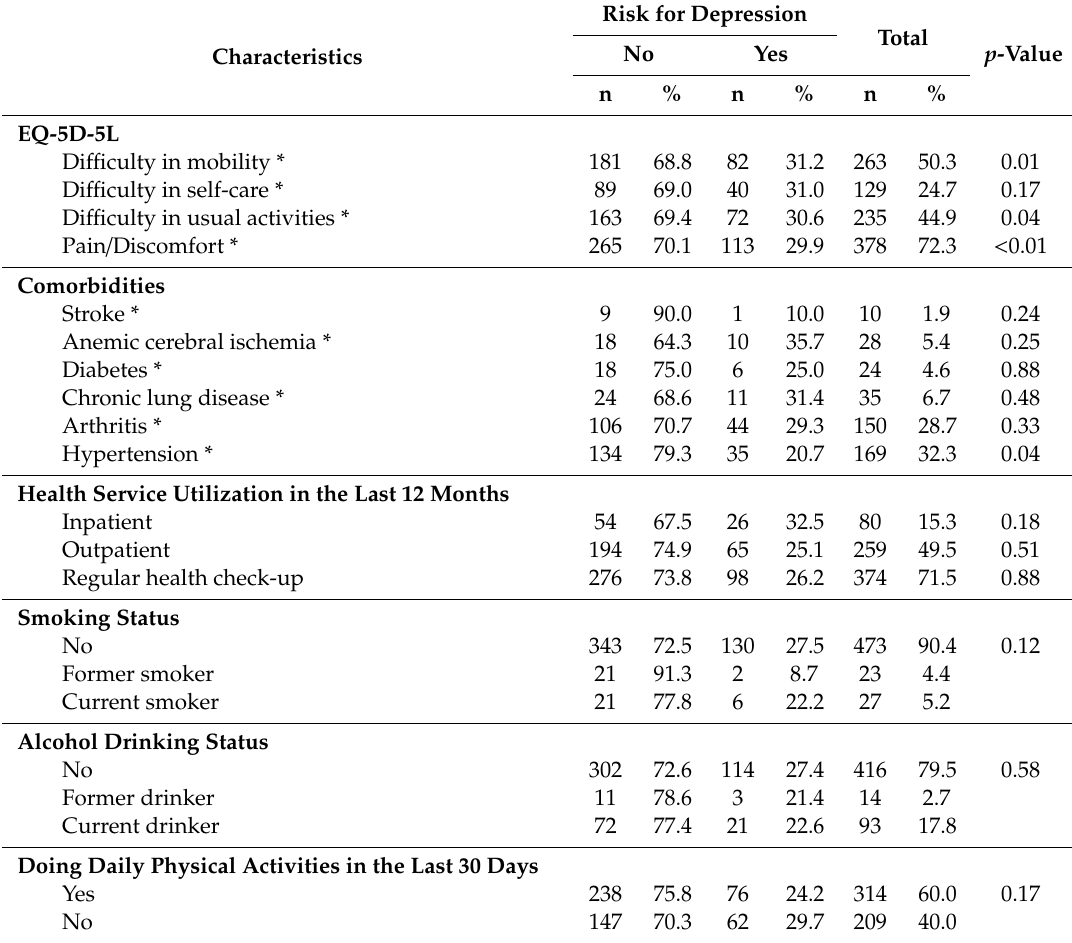
Table 3. Health status, health utilization, and behavior (smoking / drinking / doing physical activities) of respondents.